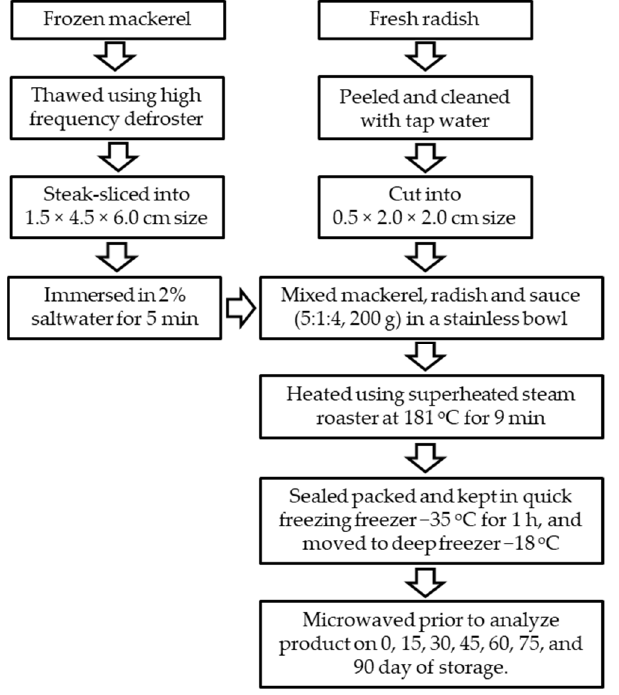
Figure 1. The processing scheme of home meal replacement braised mackerel with radish.